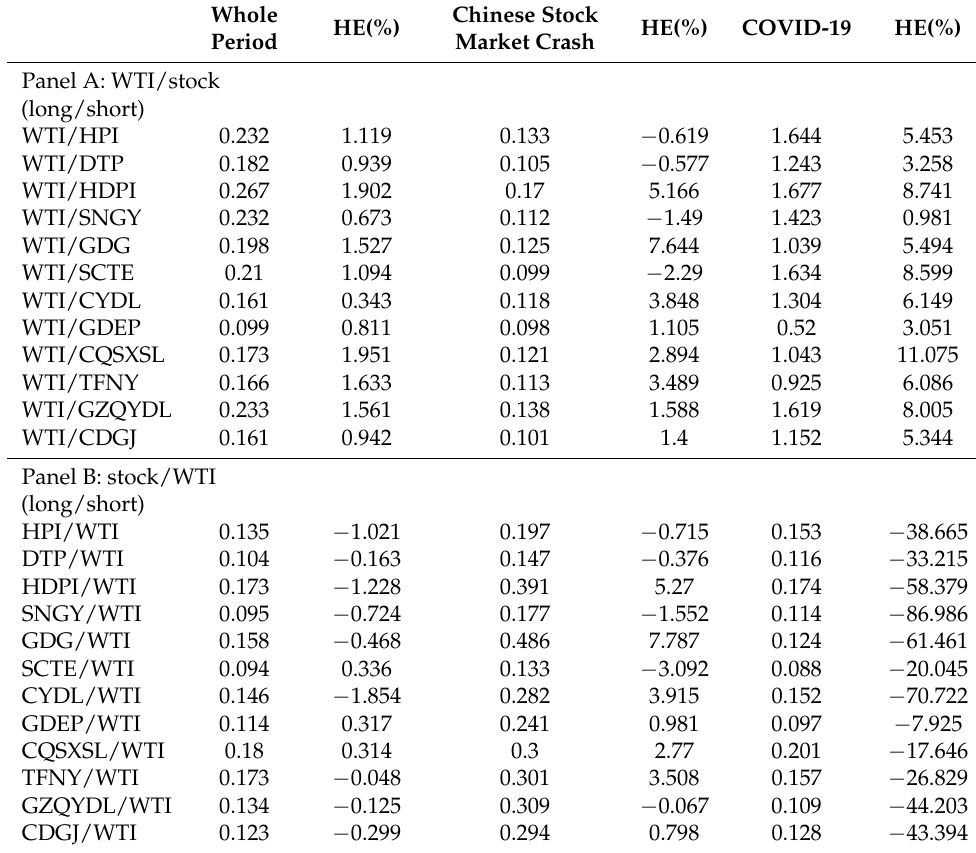
Table 4. Hedge ratios and the corresponding hedging effectiveness for WTI and electricity